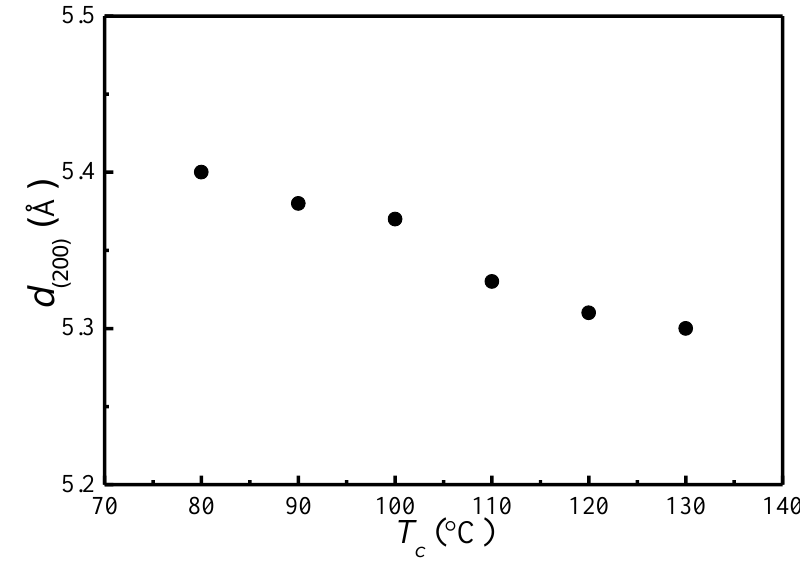
Figure 2. (200)/(110) lattice spacing as a function of T c .